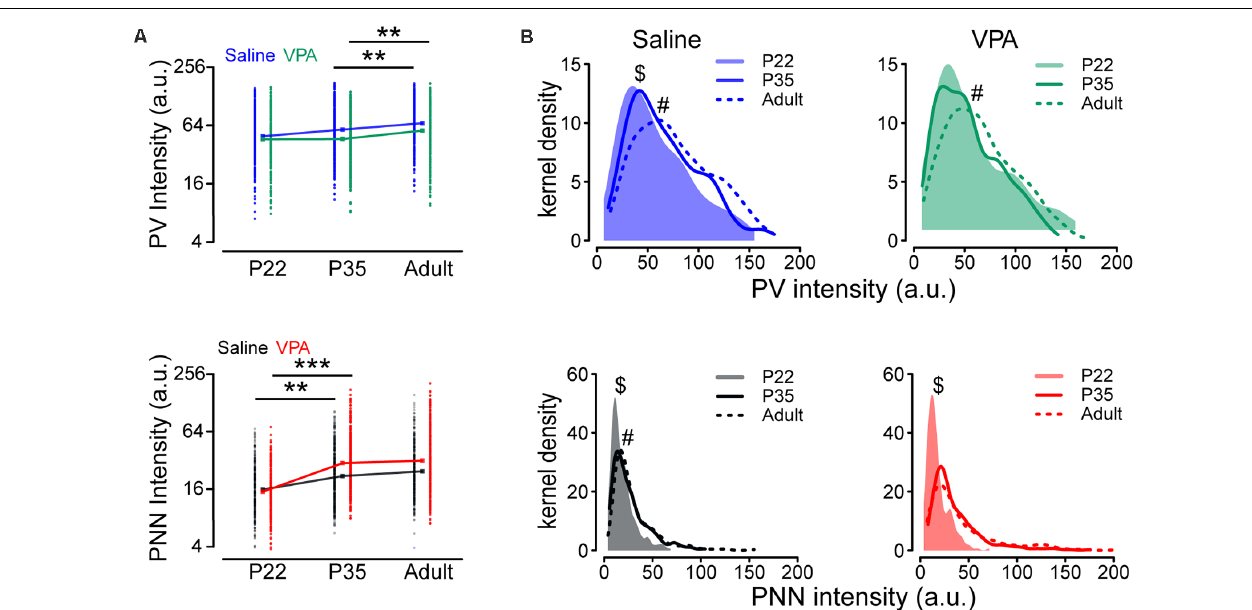
FIGURE 6 | Altered intensities of PV and PNN in VPA mice during postnatal development. (A) PV and PNN intensities in PrL-PFC of P22, P35, and adult saline and VPA mice. (B) Kernel density estimation of the PV and PNN intensities in PrL-PFC of P22, P35, and adult mice. Points in panel (A) represent observed PV and PNN intensities, while rectangles indicate geometric means. Linear mixed models were applied to compare the means of logarithm transformations of PV intensity [log(PV)] and PNN intensity [log(PNN)] between groups using cells as the statistical units. Kolmogorov-Smirnov tests were employed to assess disparities in the distribution of PV intensity between groups using cells as the statistical units. N = 287, 366, and 351 cells in P22, P35, and adult saline groups, respectively. N = 242, 305, and 348 cells in P22, P35, and adult VPA groups, respectively. ** P < 0.01, *** P < 0.001. $ statistical significance between P22 and P25; # significance between P35 and adult. P -values in Supplementary Table 3